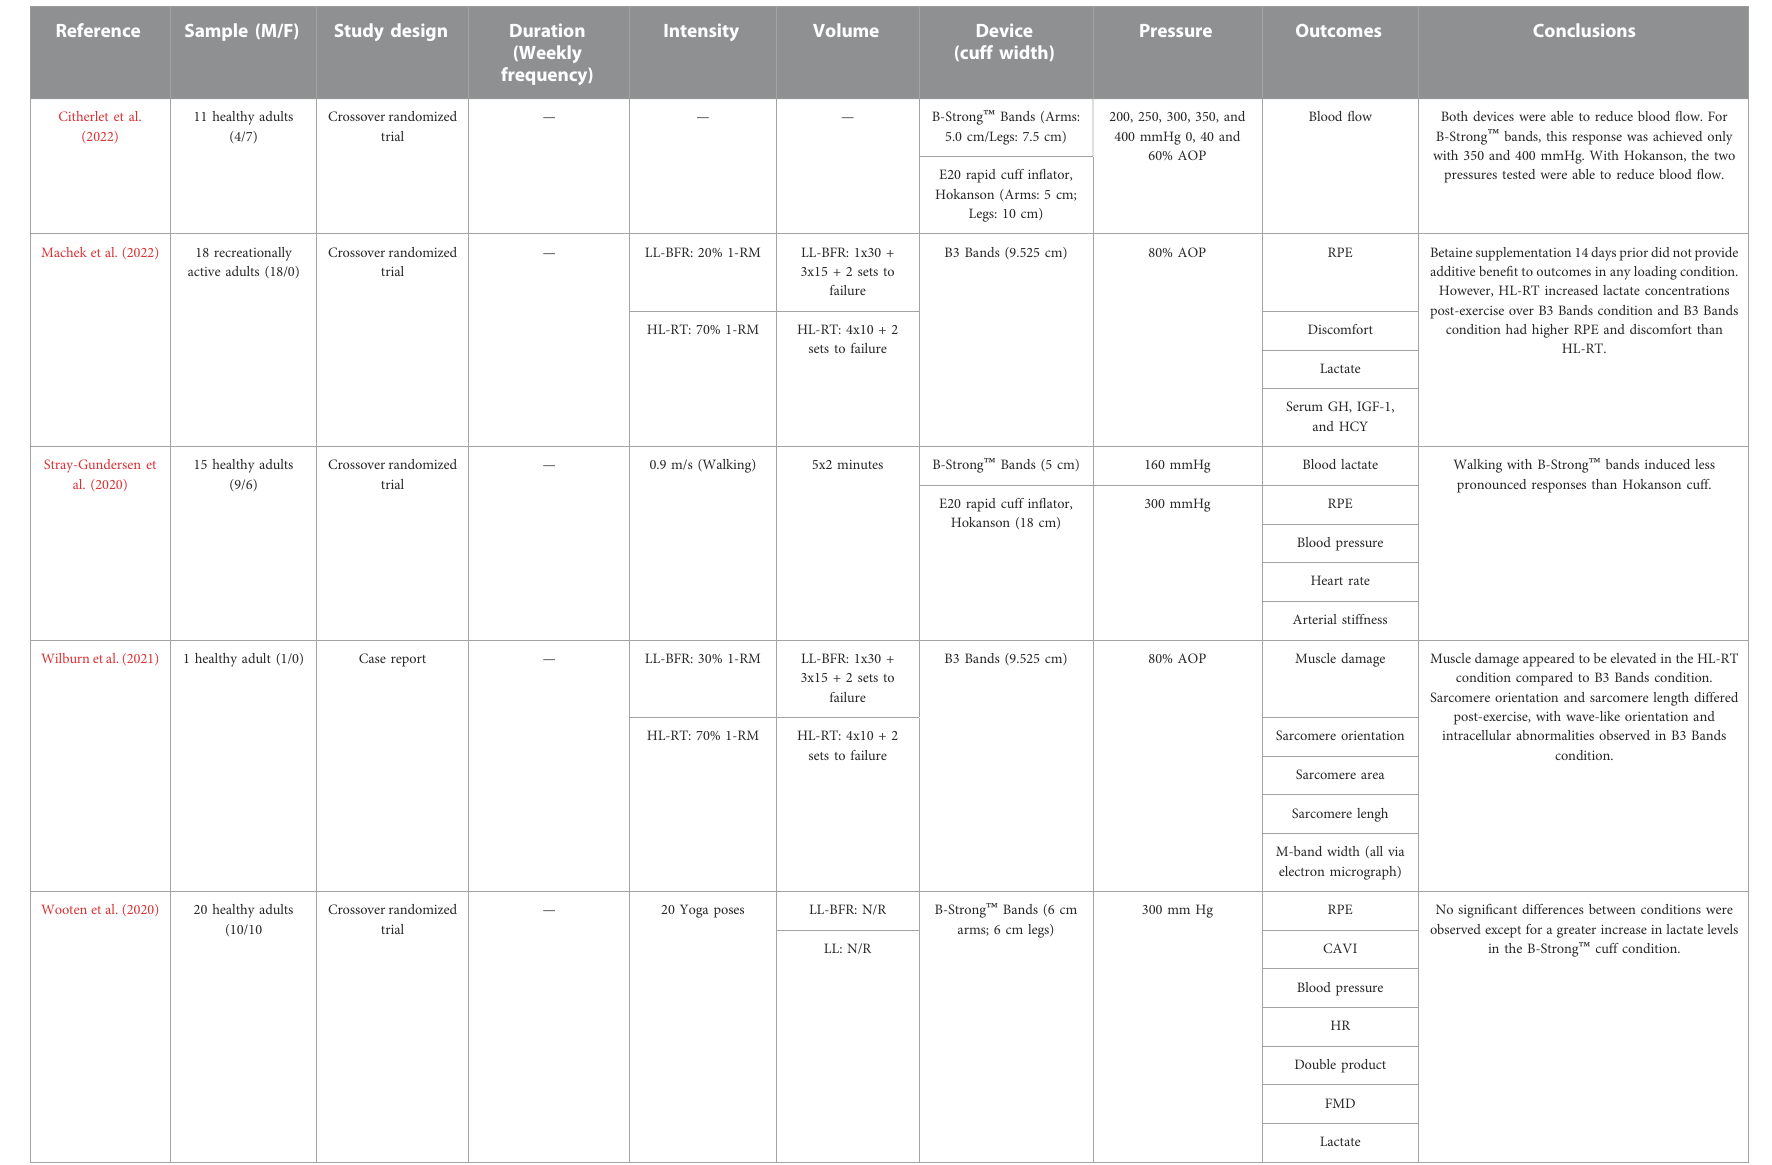
200, 250, 300, 350, and 400 mmHg 0, 40 and 60% AOP